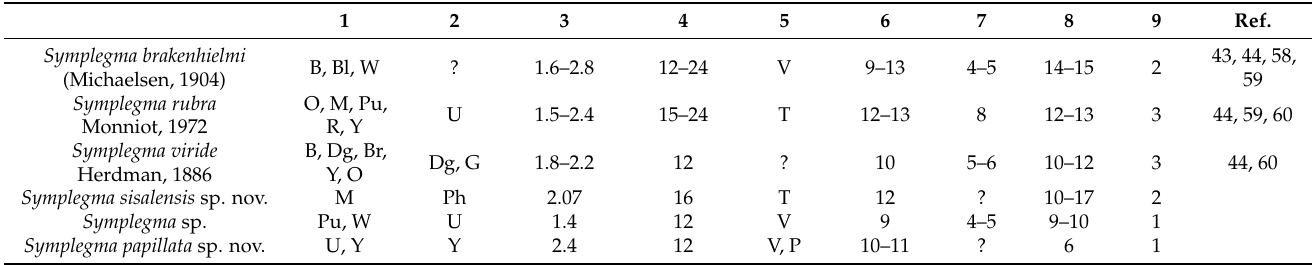
Table 2. Tabular key of Symplegma species of the Atlantic